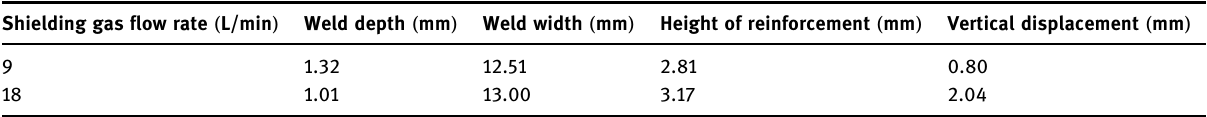
Table 4: Weld bead geometry sizes and distortion of the welds as shown in Figure 6 Shielding gas fl ow rate ( L/min ) Weld depth ( mm ) Weld width ( mm